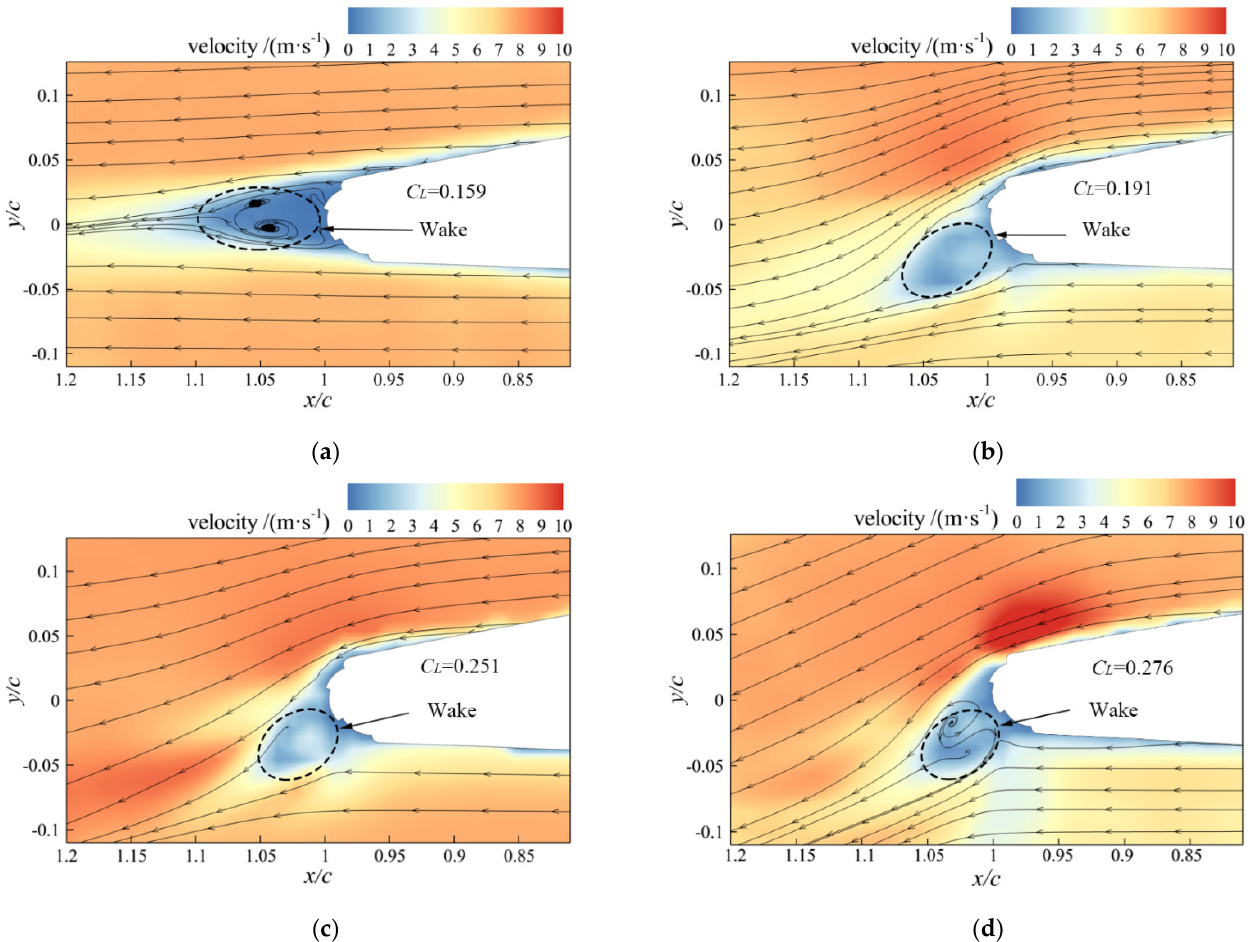
Figure 11. Comparison of velocity cloud and streamline diagrams at different numbers of slots ( U ∞ = 8 m/s, AoA = 0°). ( a ) No slot. ( b ) Single slot. ( c ) Two slots. ( d ) Three slots.